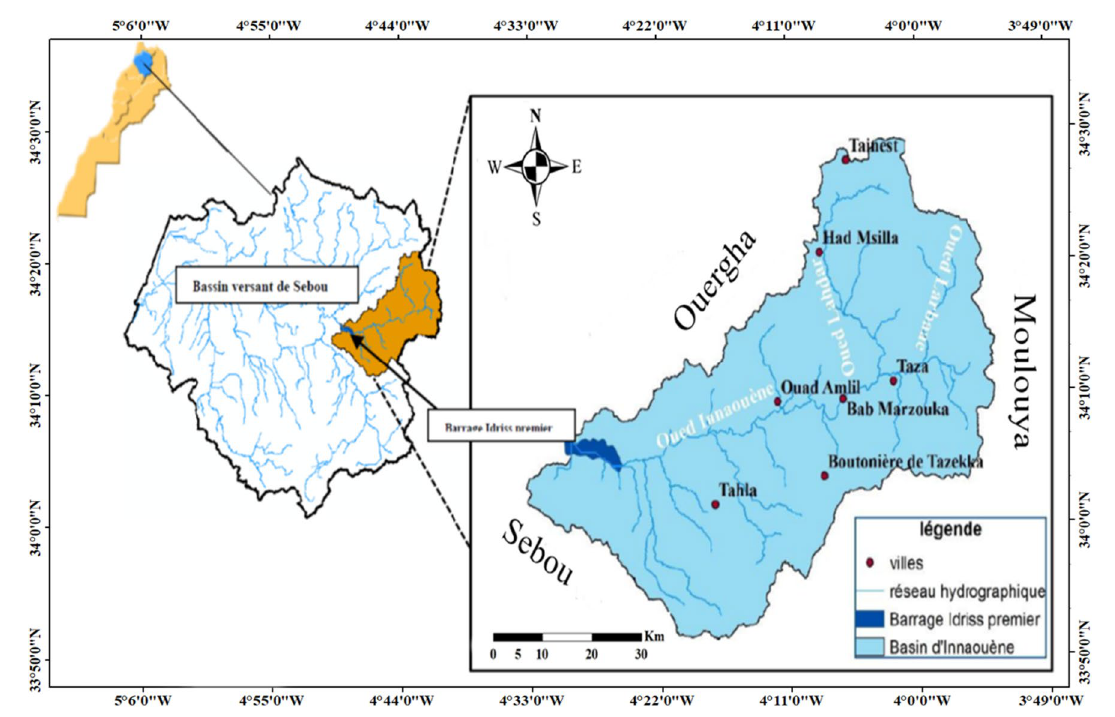
Fig. 1 Location map of Inaouene watershed (study area)